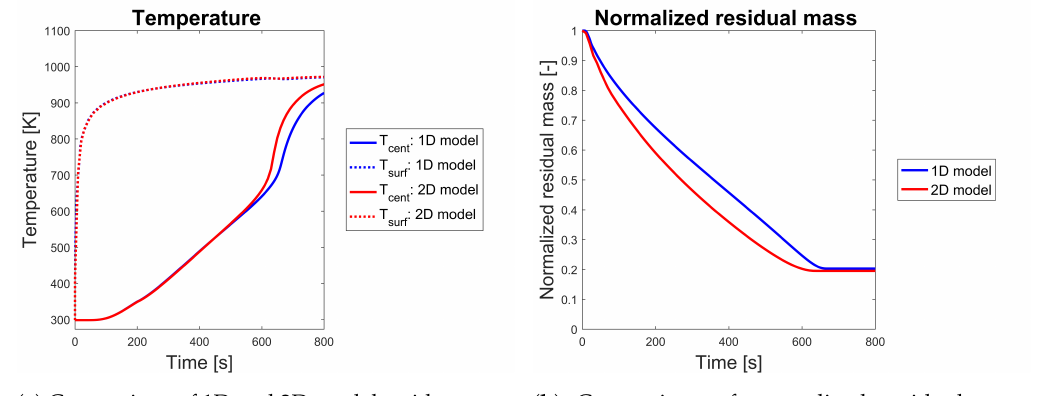
Figure 12. Comparison of degradation dynamics predicted by the 1D model and the detailed 2D model at an aspect ratio of